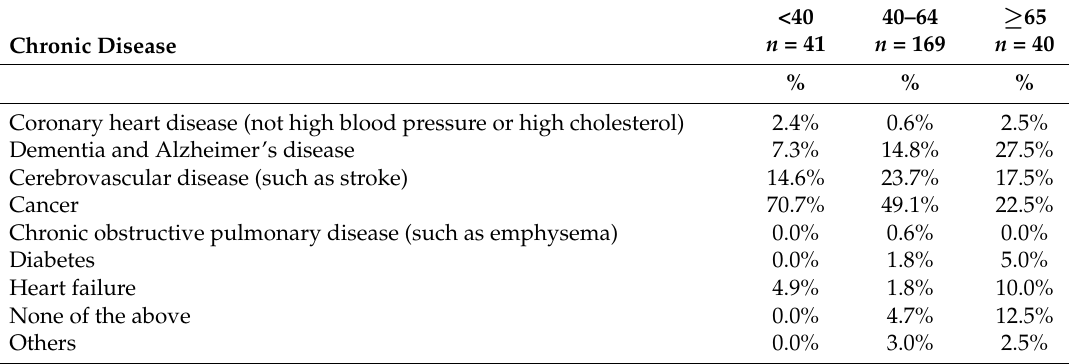
Table 1. Comparison of the most feared disease among different age-groups (select 1